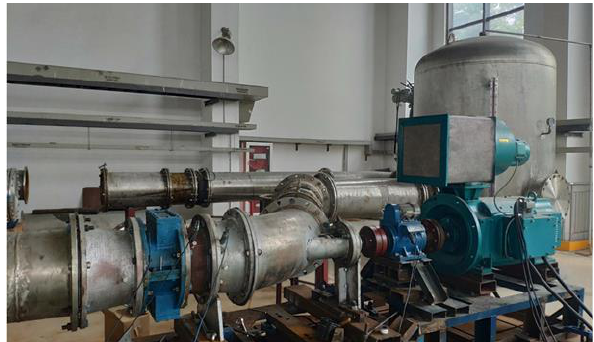
Figure 18. The experiment bench of the axial-flow pump. Processes 2020 , 8 , 309